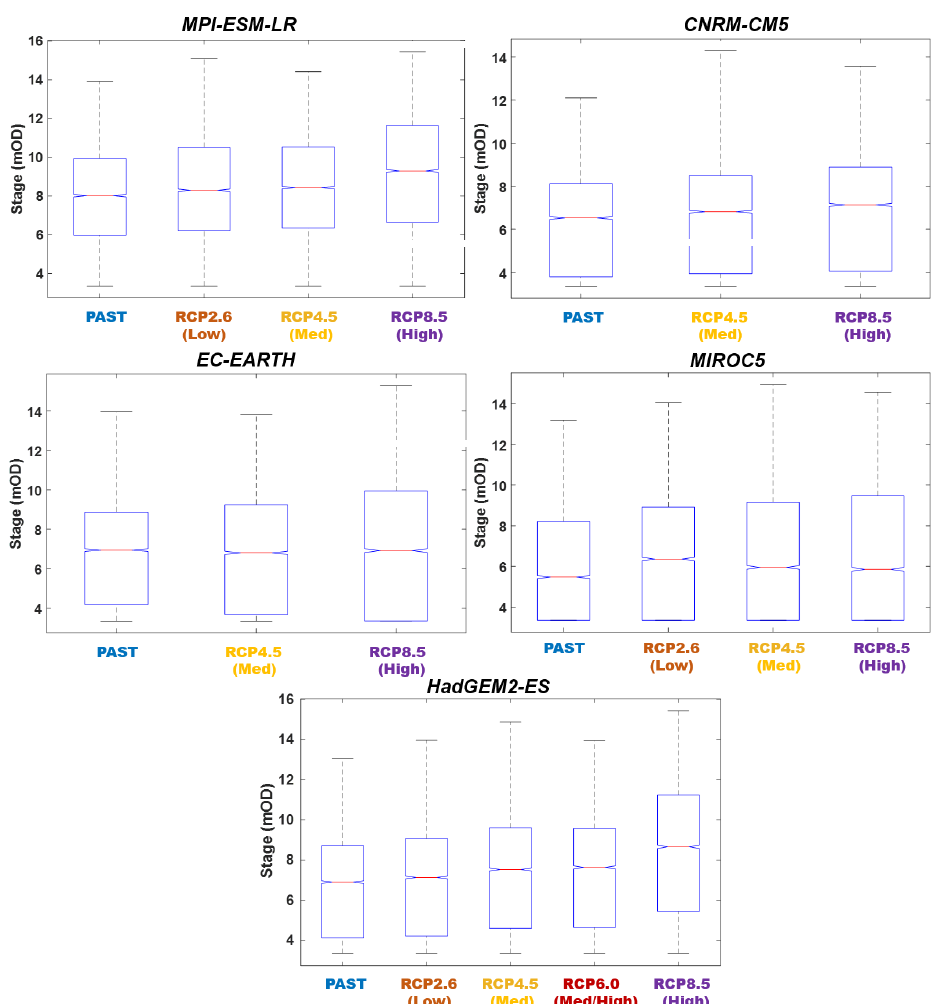
Figure 5. Box plots of model results for each of the RCMs, showing past and future RCM scenarios at Cahermore turlough. The central mark (red) indicates the median, and the bottom and top edges of the box indicate the 25th and 75th percentiles, respectively. Note that Cahermore turlough is one of the key turloughs in the catchment and is therefore representative of the general catchment trends.